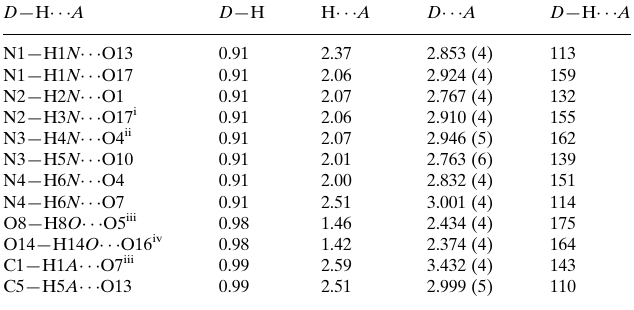
Hydrogen-bond geometry (A˚ , (cid:4) ). D —H (cid:3)(cid:3)(cid:3)